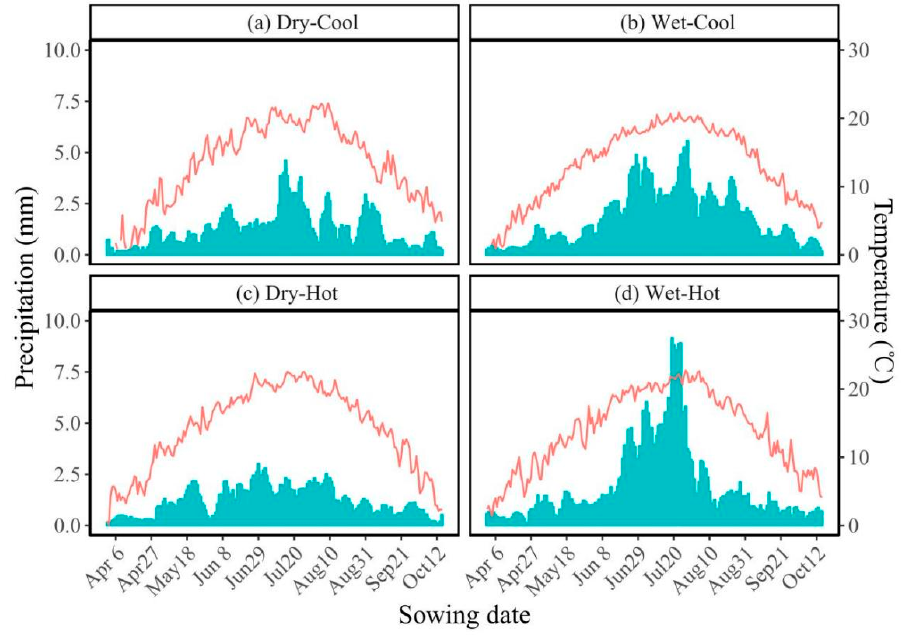
Figure 2. An example of precipitation and temperature distribution during the potato growing season in different water-temperature year types at XWZM of the APE in North China. ( a – d ) represent the dry-cool year, wet-cool year, dry-hot year and wet-hot year, respectively.